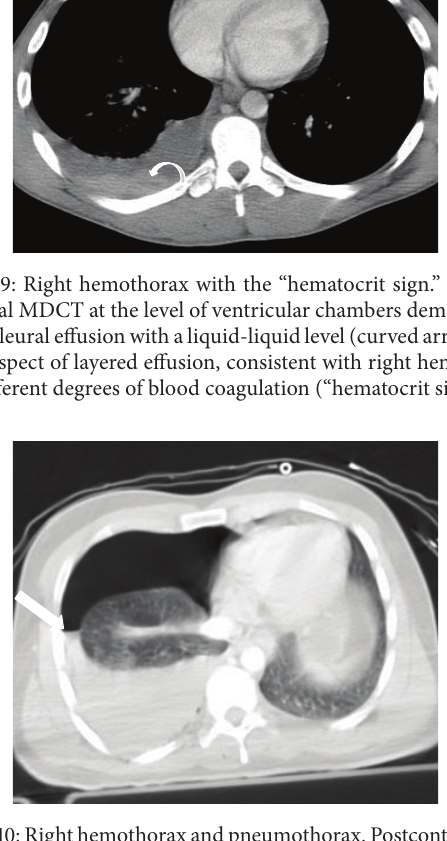
Figure 10: Right hemothorax and pneumothorax. Postcontrast axial MCDT shows a right hemopneumothorax creating an air-liquid level